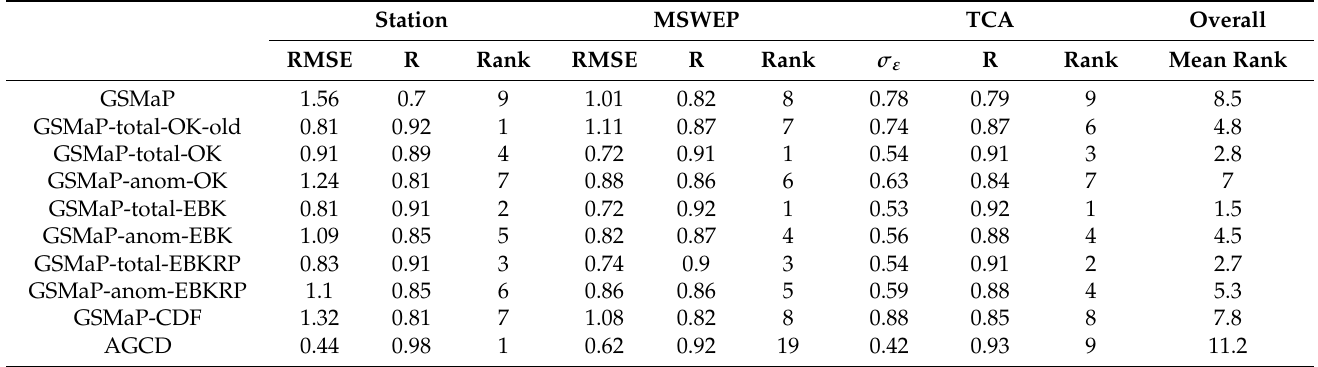
Table 2. Verification statistics for the corrected datasets with GSMaP included as a